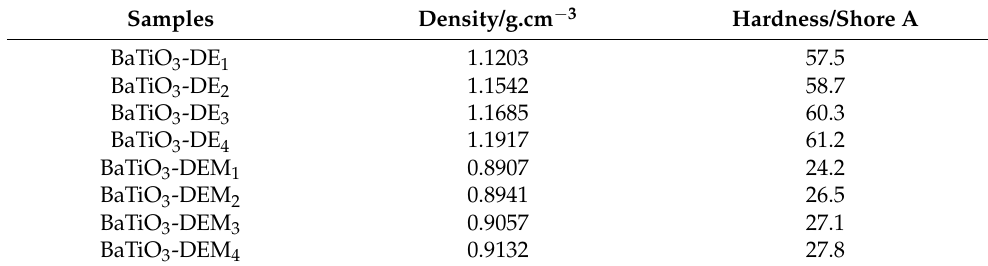
Table 6. Density and hardness between two kinds of samples.